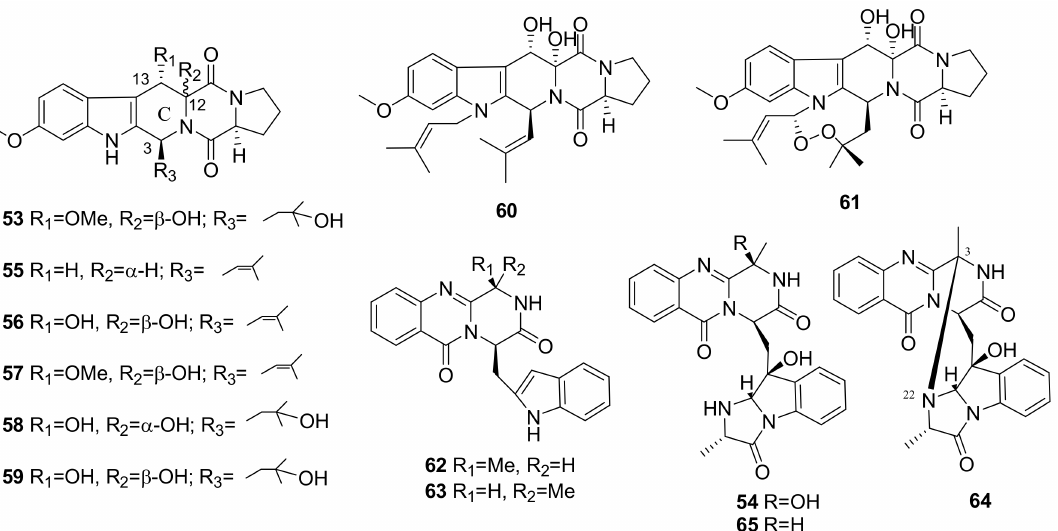
Figure 4. The structures of 12 β -hydroxy-13 α -methoxyverruculogen TR-2 ( 53 ); 3-hydroxyfumiquinazoline A ( 54 ); fumitremorgin C ( 55 ); cyclotryprostatins A ( 56 ) and B ( 57 ); verruculogen TR-2 ( 58 ); 12 β -hydroxyverruculogen TR-2 ( 59 ); fumitremorgin B ( 60 ); verruculogen ( 61 ); and fumiquinazolines F, G, D, and A ( 62 − 65